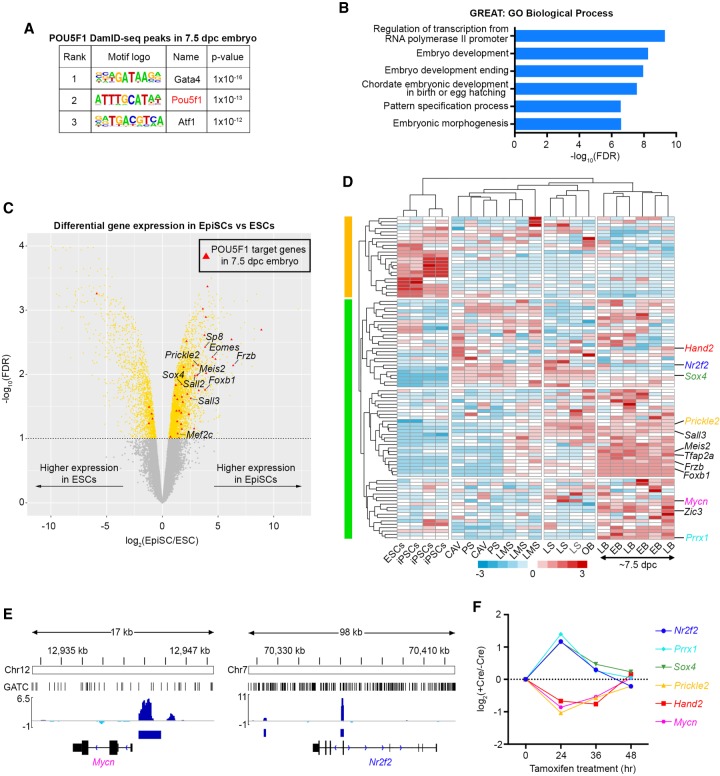
Analysis of POU5F1 target genes in the 7.5-dpc epiblasts. (A) Motif enrichment analysis (Heinz et al. 2010) of the epiblast POU5F1 DamID-seq peaks. (B) GO enrichment analysis of POU5F1 DamID-seq peaks from 7.5-dpc epiblasts using GREAT (McLean et al. 2010). (C) Differentially expressed genes between ESCs and EpiSCs (Tesar et al. 2007). Red triangles represent the POU5F1 binding peak–associated genes in 7.5-dpc epiblasts. (D) Expression levels of the 7.5-dpc epiblast POU5F1 binding peak–associated genes in ESCs and post-implantation epiblasts (Kojima et al. 2014). Genes whose expression significantly changed 24 h after Pou5f1 deletion in the 7.5-dpc mouse embryo (DeVeale et al. 2013) are indicated in color. (CAV) Epiblast of cavity; (PS) prestreak; (LMS) late mid streak; (LS) late streak; (OB) no bud; (EB) early bud; (LB) late-bud. (E,F) POU5F1 binding peaks identified by DamID-seq (E) and expression changes of the development-related six genes upon Pou5f1 deletion in 7.5-dpc embryos (F) (DeVeale et al. 2013).